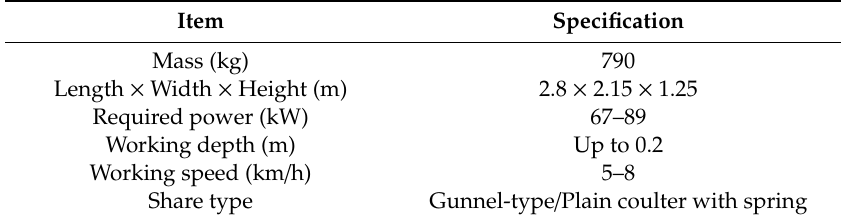
Table 1. Specification of the moldboard plow used in this